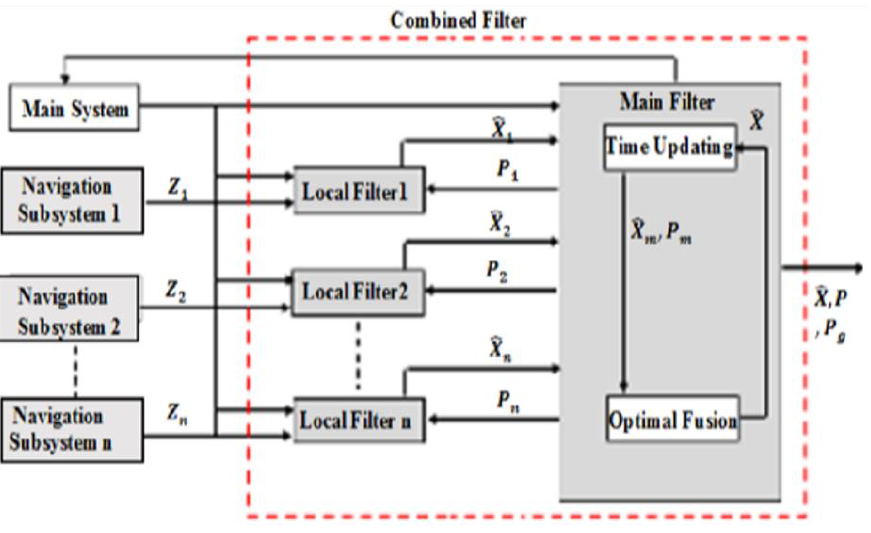
Figure 4. Combined filter basics.